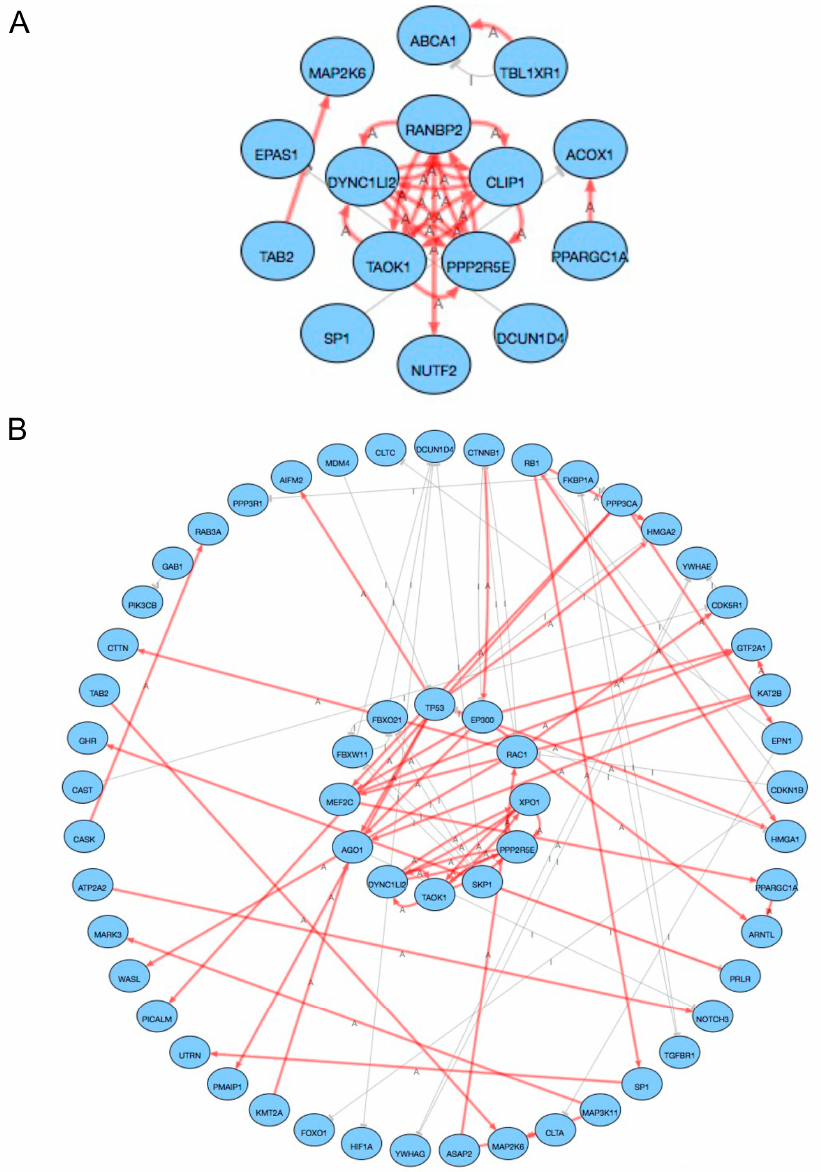
Figure 6. Hub gene networks of in silico predicted miRNA target genes. ( A ) Network of target genes related to miRNAs upregulated in BM. ( B ) Network of target genes related to miRNAs downregulated in BM. Connections marked “A” display activation. Connections marked “I” display inhibition.